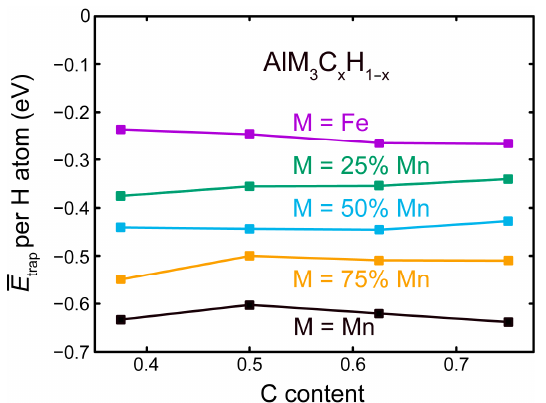
Figure 3. Average trapping energy Ē trap per H atom as a function of the C content for a 3 × 3 × 3 E 2 1 -(Fe,Mn) 3 Al(C,H) supercell with all κ positions filled and considering different Mn contents.